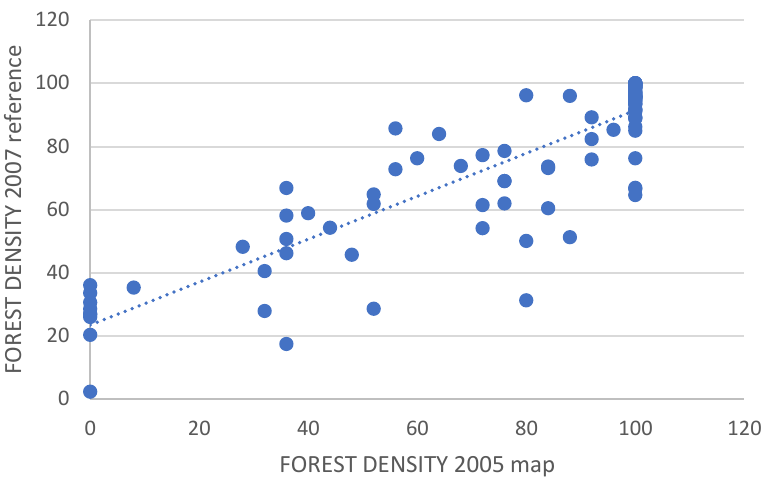
Table 3. Correlation between Forest Density value of reference data and map product. Epoch Coeff. Correlation R 2 between Reference and Product